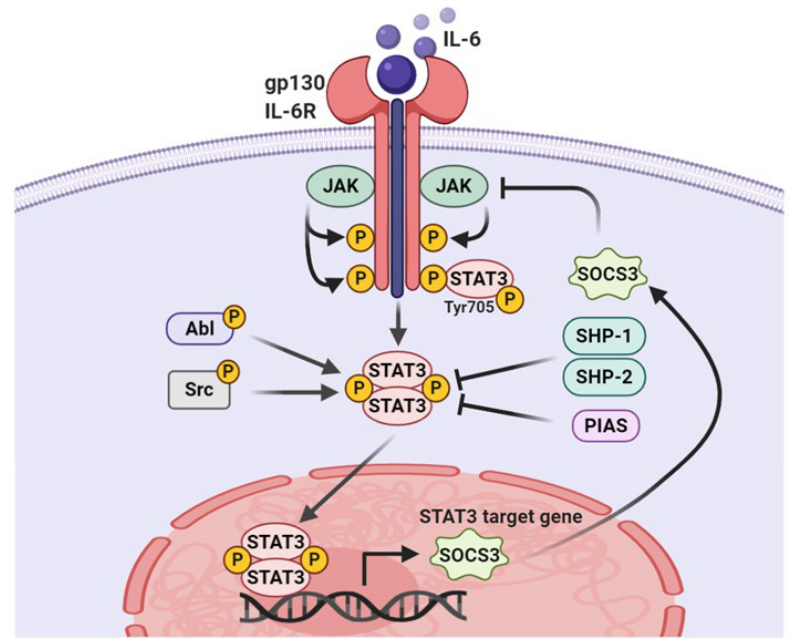
Figure 1. Functional domain of STAT3. The STAT3 protein consists of 770 amino acids and is divided into 5 distinct functional domains: the N-terminal domain, coiled-coil domain, DNA-binding domain, Src homology 2 (SH2) domain, and C-terminal transactivation domain.